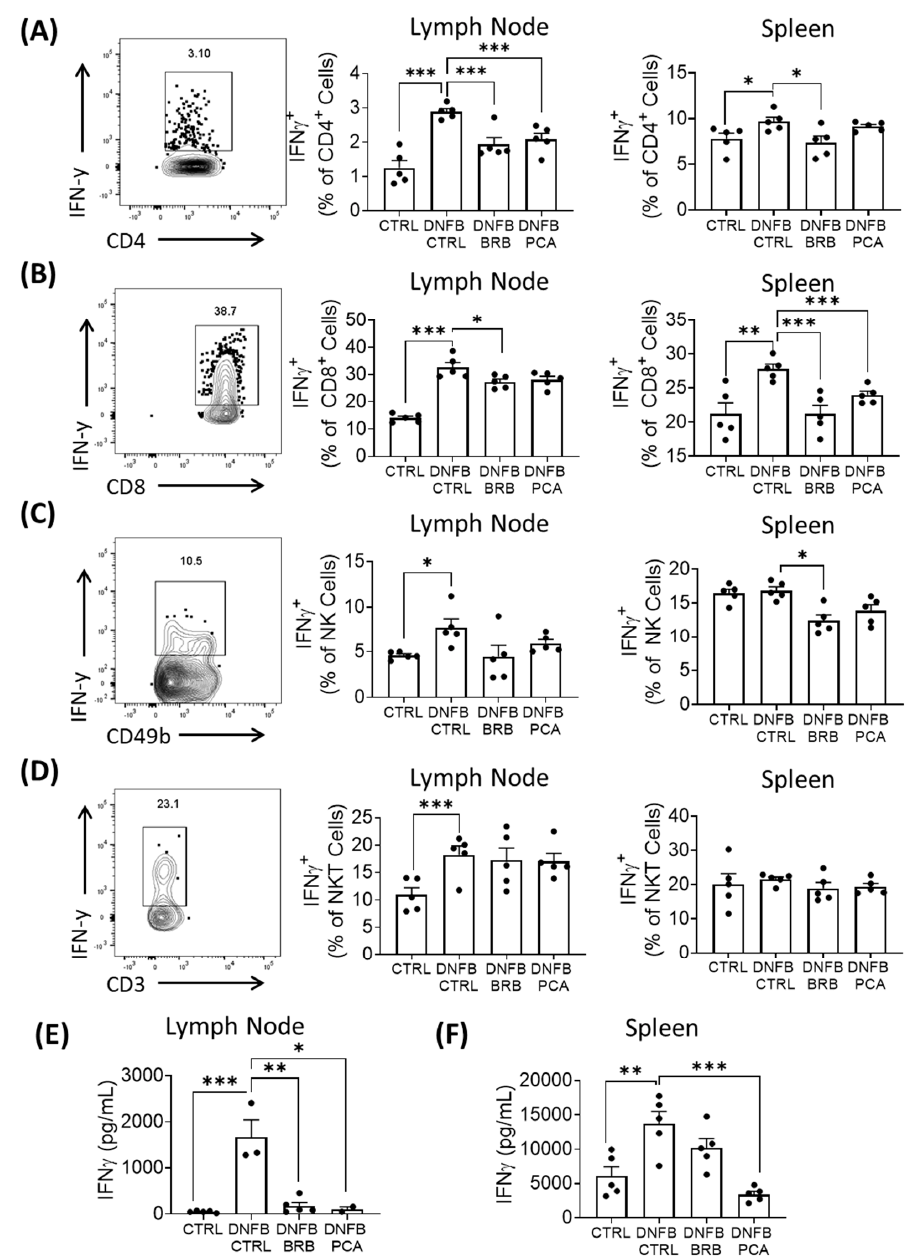
Figure 4. IFN- γ production is attenuated in DNFB challenged mice fed BRB and, to a lesser extent, PCA supplemented diets. ( A , B ) Frequency of IFN- γ expression by ( A ) CD4 + cells, ( B ) CD8 + cells, ( C ) CD49b + CD3 − NK cell, and ( D ) CD49b + CD3 + NKT cells within the draining lymph nodes and spleens of experimental mice, determined by flow cytometry. Representative graphs of the gated populations are shown. ( E , F ) Production of IFN γ by CD3 stimulated T-cells, isolated from the lymph nodes and spleens. Concentrations in the supernatants of plated T-cells were determined by ELISA after 24-h incubation for lymph nodal populations, and after 72 h incubations for splenic populations. * p -value < 0.05; ** p -value < 0.01; *** p -value < 0.005 for comparisons between DNFB-challenged mice fed control diet and comparison group using Student’s t test, and for comparisons between DMSO control samples and comparison groups.